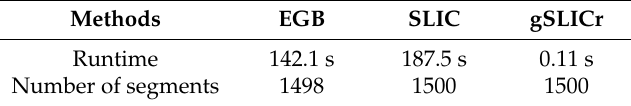
Table 4. Comparison of initial segmentation.